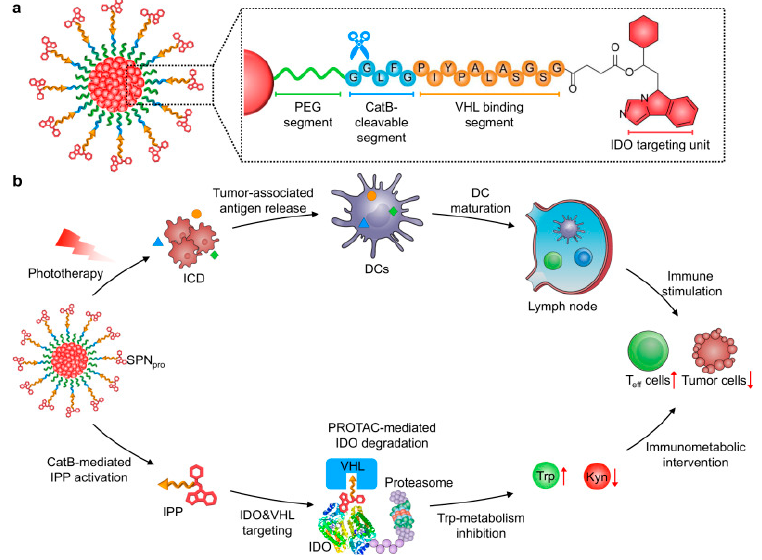
Figure 2. Schematic illustration of SPNpro-mediated IDO degradation for cancer photo-immunometabolic therapy. ( a ) Structure and CatB-specific activation mechanism of SPNpro. ( b ) SPNpro-mediated activatable photo-immunometabolic therapy with two processes: (i) a series of cancer immune re- sponses including immunogenic cell death (ICD), tumor-associated antigen release, DC maturation, and effector T (Teff) cell activation upon NIR photoirradiation; (ii) SPNpro-mediated immunometabolic intervention processes including CatB-specific activation of IPP, IDO and VHL targeting, proteasome recruitment, IDO degradation, Trp upregulation and Kyn depletion, and Teff cell activation. Reproduced from ref. [120] with permission from the Nature Publishing Group.